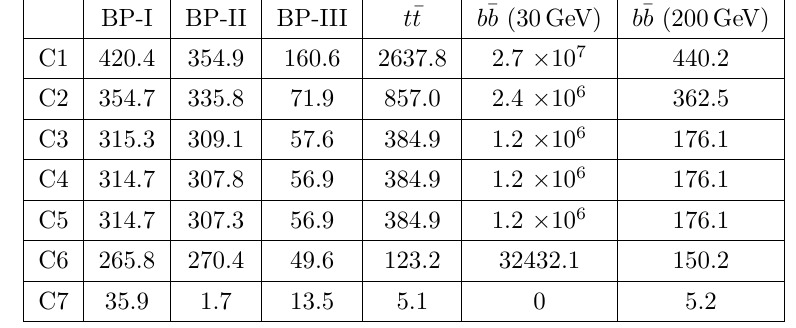
√ s = 13 TeV and L = 137 fb − 1 ).